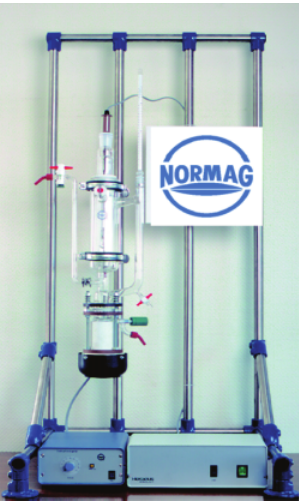
Figure 1: The NORMAG photoreactor.